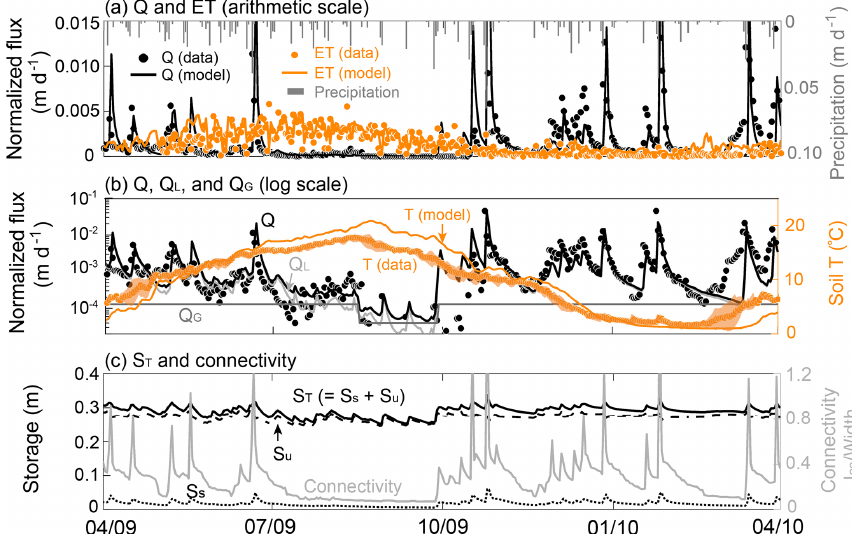
Figure 3. Temporal dynamics of (a) daily precipitation, stream discharge Q , and evapotranspiration ET on the arithmetic scale; (b) stream discharge Q , soil water interflow Q L , and groundwater Q G on a logarithmic scale with soil T on an arithmetic axis (right); (c) soil water storage S T (unsaturated water storage S u + saturated water storage S s ) and hydrological connectivity I cs / Width. The yellow dots in panel (b) represent the average soil T from three sampling locations (square symbols in Fig. 1b) with the shading reflecting variation in measurement. Q was highly responsive to intense precipitation events in spring and winter. Note high soil T , high ET, low S s , and low I cs / Width during July–August 2009. Stream discharge was primarily comprised of Q L , except in July–October when the relative contribution of Q G